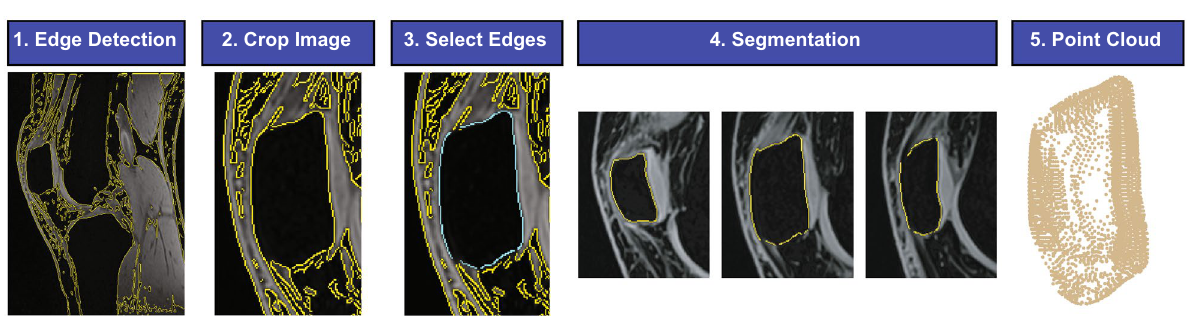
Figure 3. Imaging protocols for the in vivo and ex vivo arms of the experiment. ( A ) T1 VIBE and DESS MR images were acquired of each human (in vivo) participant’s dominant knee. ( B ) The porcine (ex vivo) imaging protocol consisted of CT imaging followed by the same T1 VIBE MRI sequence performed on the human participants. T1 VIBE T1-weighted Volume-Interpolated Breathhold Examination with Water Excitation, DESS Double Echo Steady-State, MR magnetic resonance, CT computed tomography.